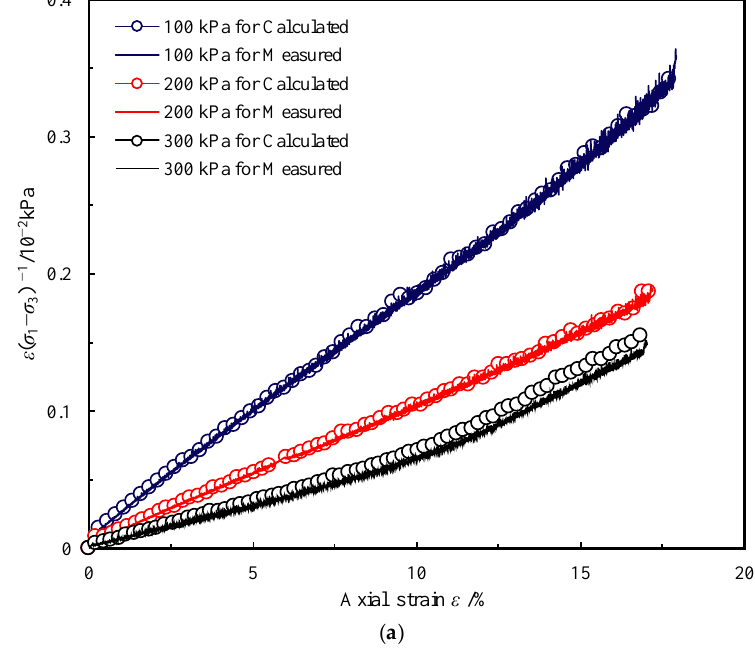
Figure 12. Normalized stress–strain curves with ( σ − σ ) adopted as the normalized factor. 3 1 ulti